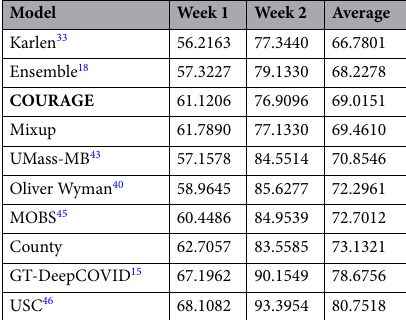
Table 3. Comparison among different models for average MAE (from 2020-11-07 to 2021-02-06).